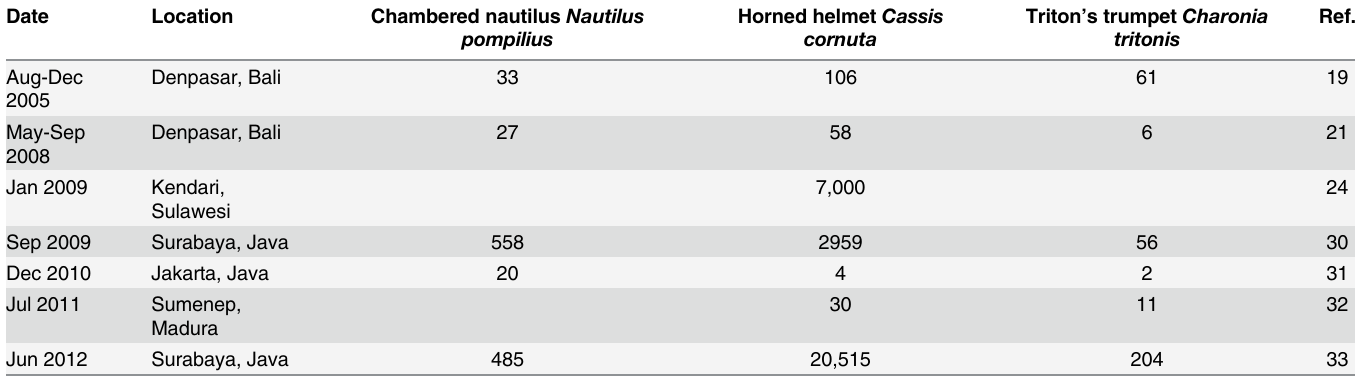
Table 2. Confiscated marine shells. Large-scale seizures ( > 25 individuals) of three species of large marine molluscs in western Indonesia (see text for